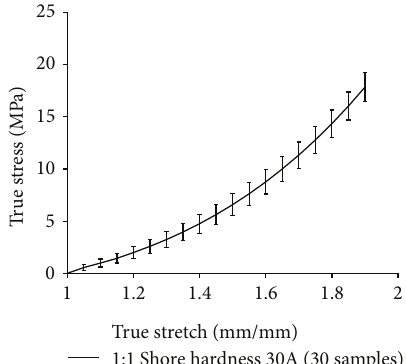
Figure 3: Stress-versus-stretch plots of 30 coupons with a 1: 1 ratio of a two-part elastomer with a shore hardness of 30A, simulating fi ber